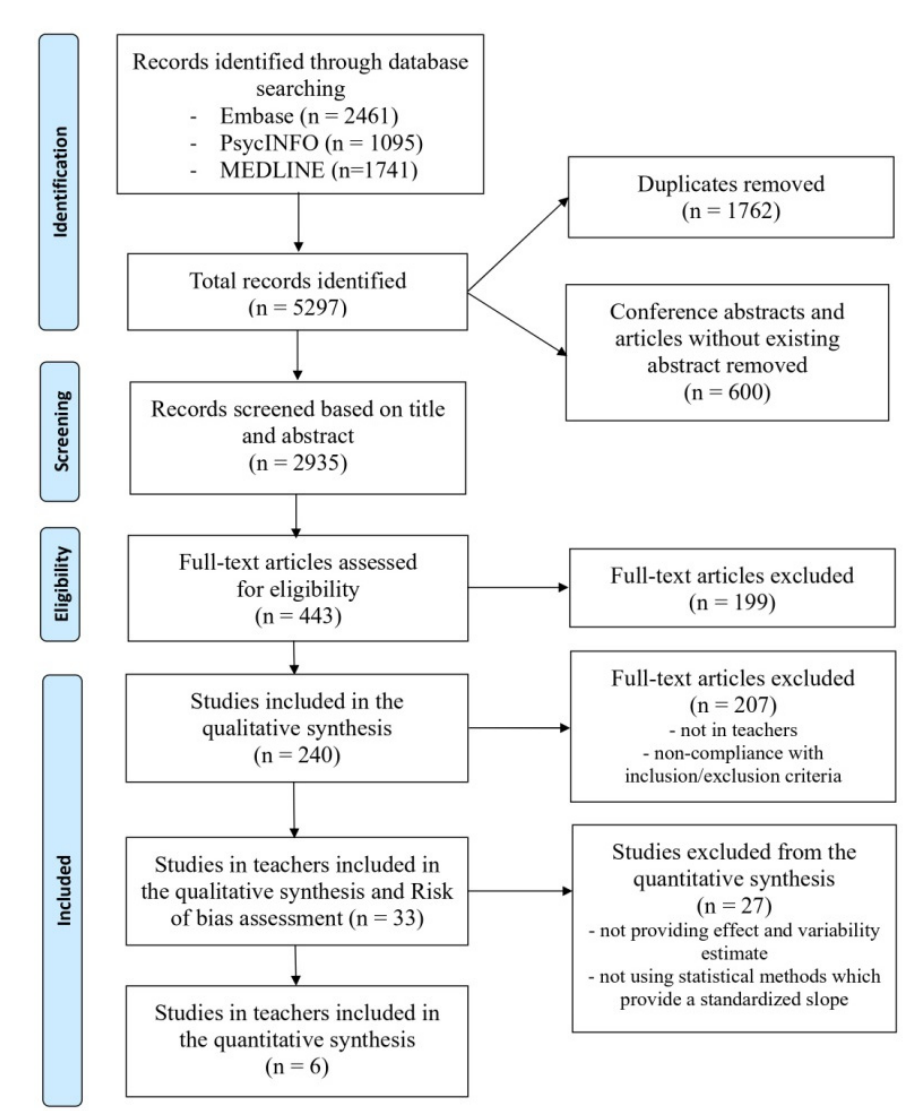
Figure 1. Flow chart of study identification and selection process. Table 1. Characteristics of studies on burnout among teachers ( n = 33).